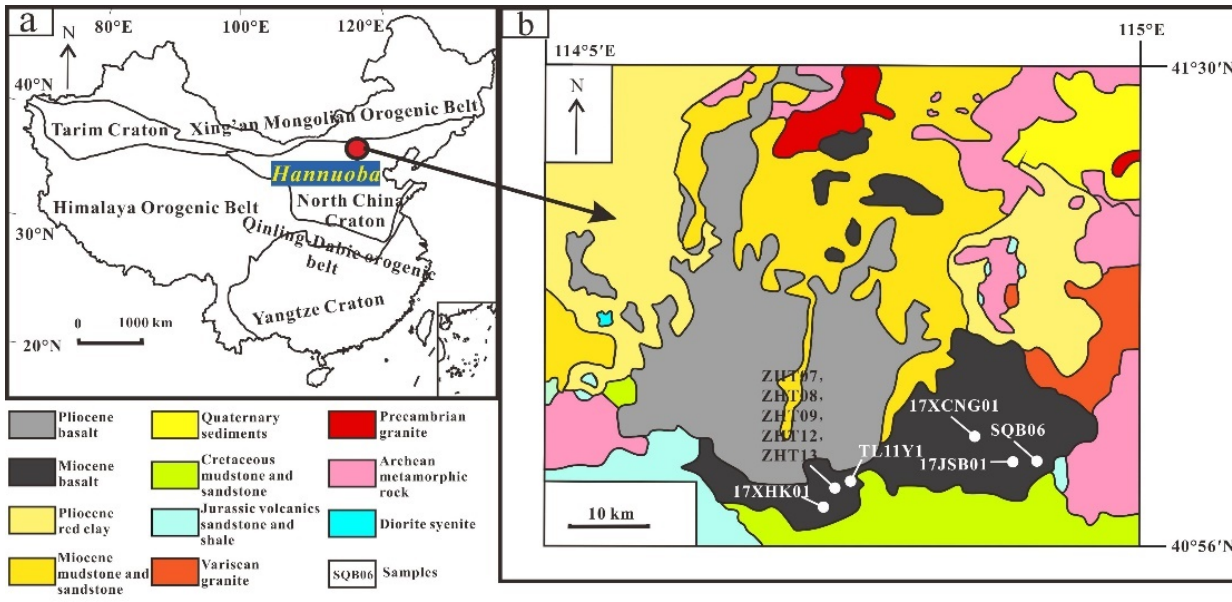
Figure 1. The location of Hannuoba basalt in China ( a ) and the geologic map of Hannuoba ( b ). The geologic map of Hannuoba was modified by Zhi et al. [54].